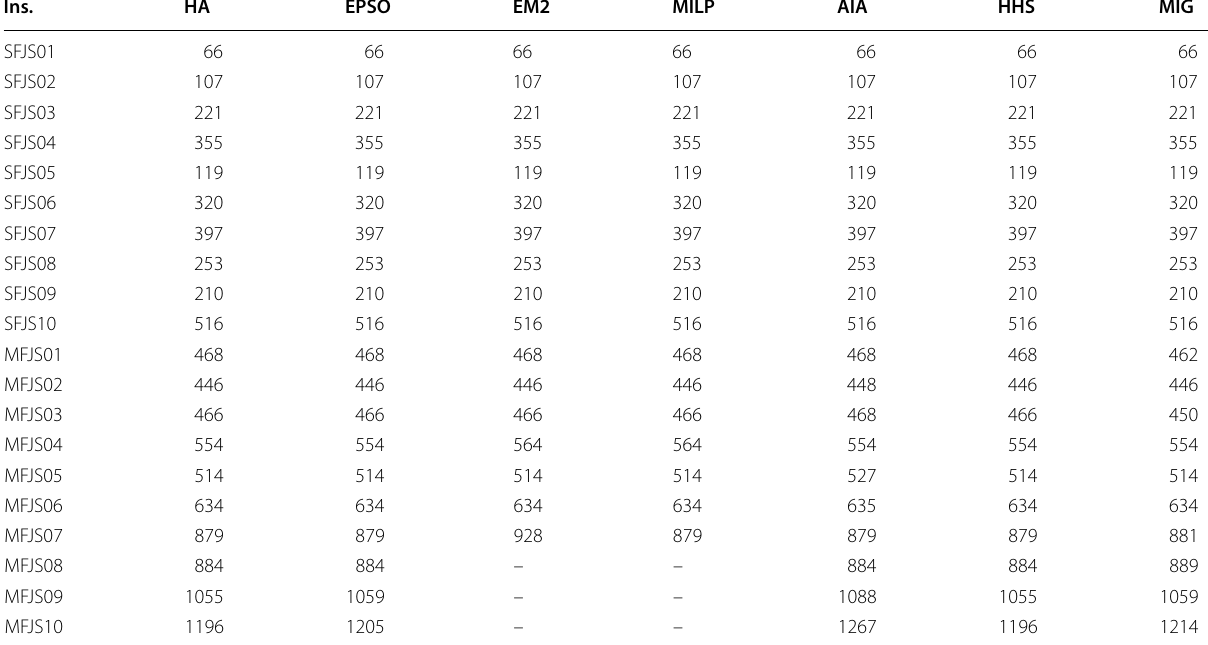
Table 3 Results of experiment 2 Ins.